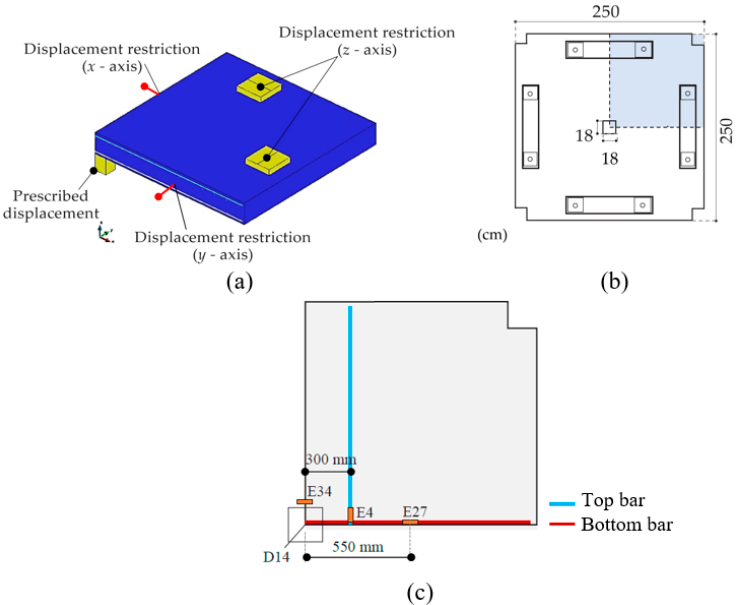
Figure 6. ( a ) Numerical model M1 and boundary conditions, ( b ) Characteristics of the experimental model, and ( c ) Position of extensometers on the reinforcement.